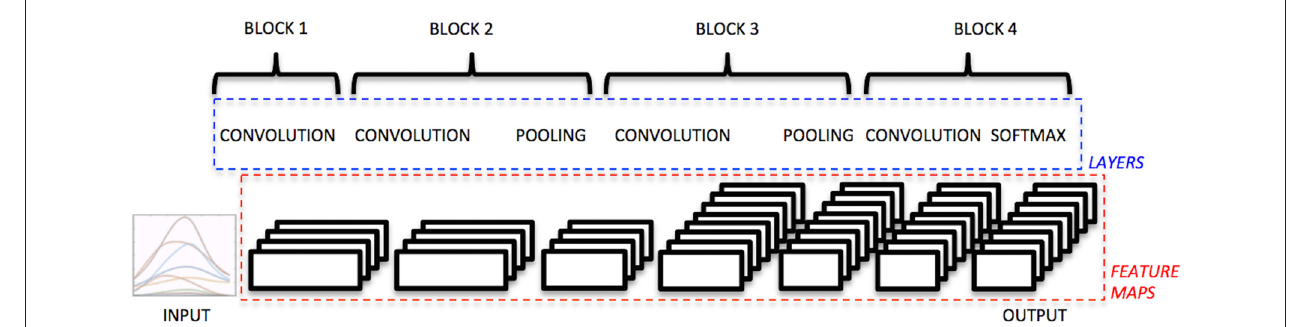
FIGURE 1 | Architecture of the convolutional neural network used on the sEMG